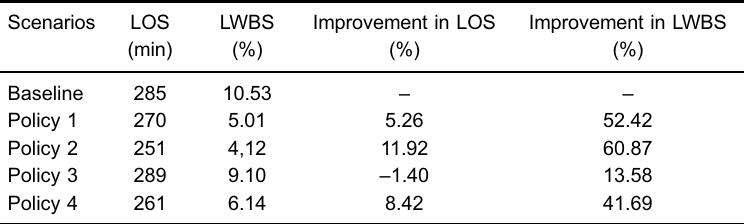
Table 2. Comparing the impact of preventive policies on LOS and